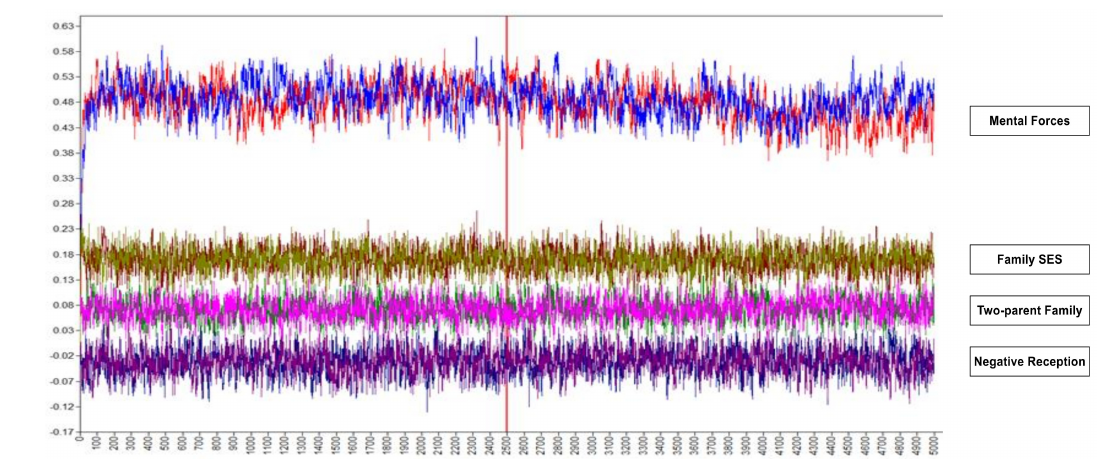
Figure A1. Bayesian posterior parameters trace plot presenting the effects of mental forces, two-parent families, family SES, and negative reception in parallel on immigrant children’s college graduation. Note: The number of iterations for each Markov Chain Monte Carlo chain was modeled by setting Fbiterations = 5000 for repeated random sampling, and all individual- and school-level covariates of multilevel modeling were adjusted, PSR = 1.031.